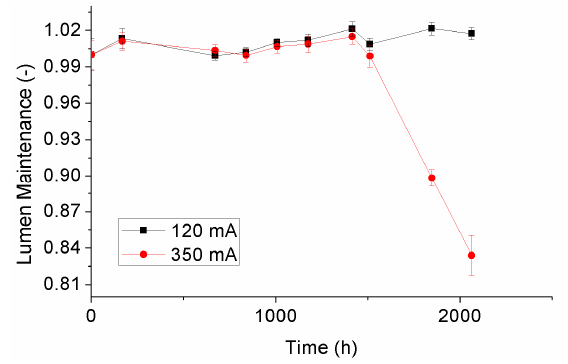
Figure 12. Lumen maintenance depreciation of the 5000 °K samples.